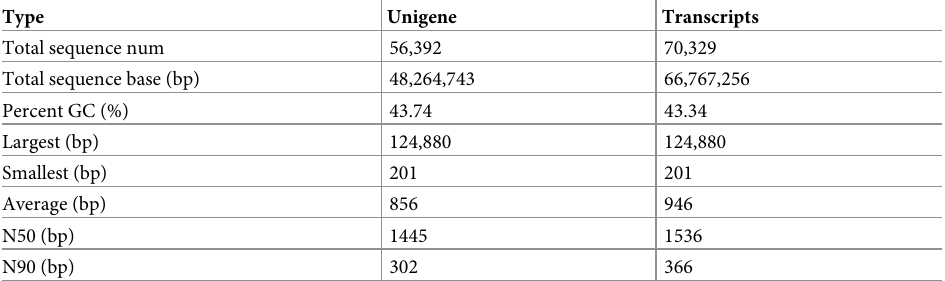
Table 1. Assembly results of unigenes and transcripts from fruit and leaf tissue of C . officinalis